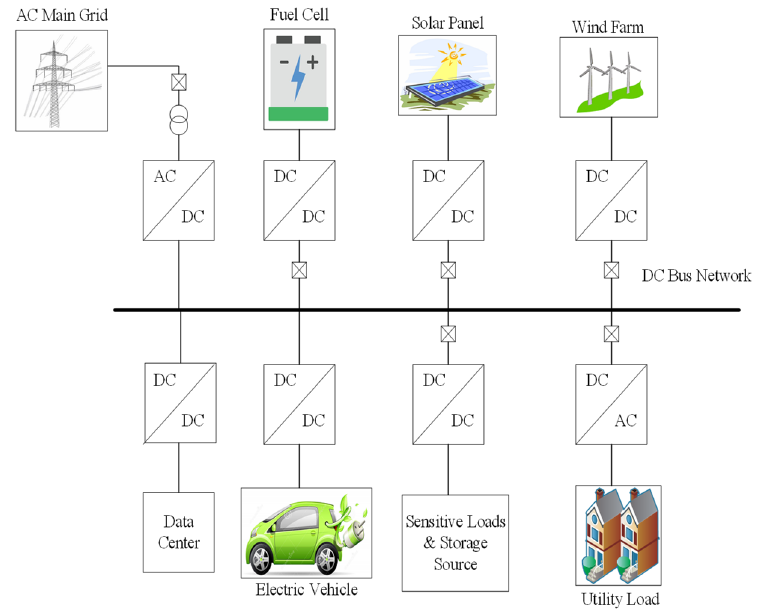
Figure 4. DC Network